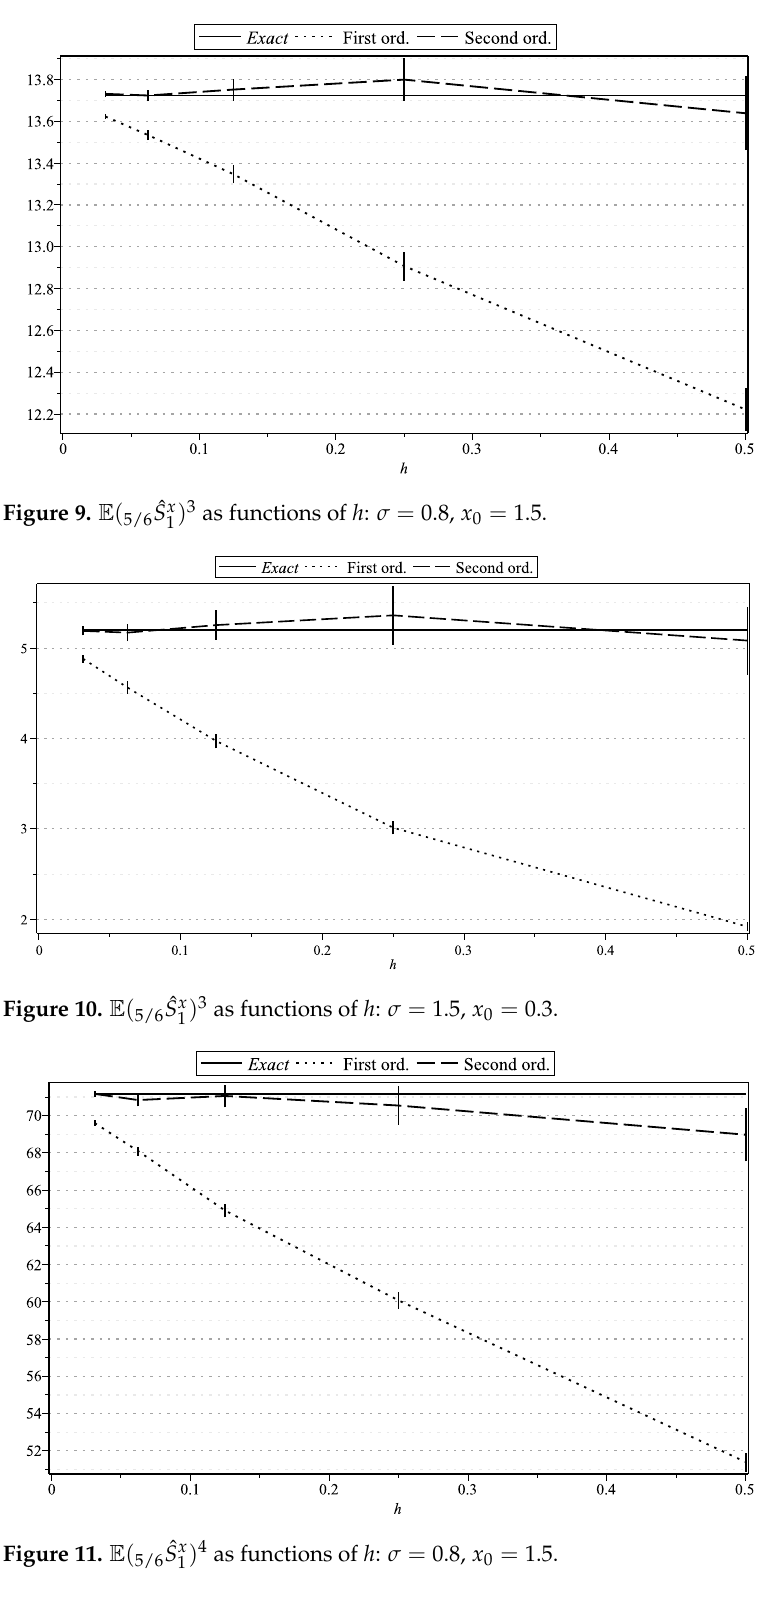
Figure 11. E ( 5/6 ˆ S x